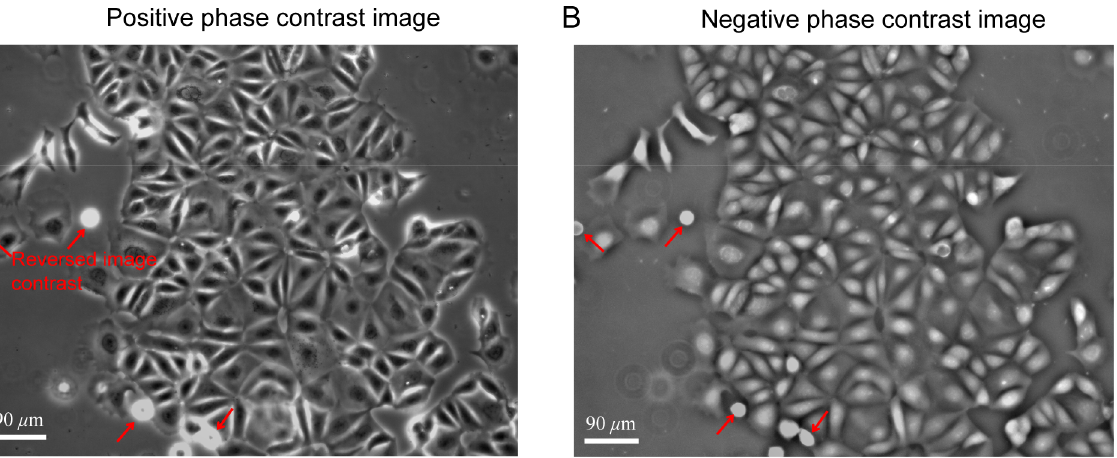
Fig 1. Comparison of positive (A) and negative (B) phase contrast images of the MCF 10A cells. In the positive phase contrast image, cells with larger height show reversed image contrast, while in the negative phase contrast image, all cells have consistent image contrast.